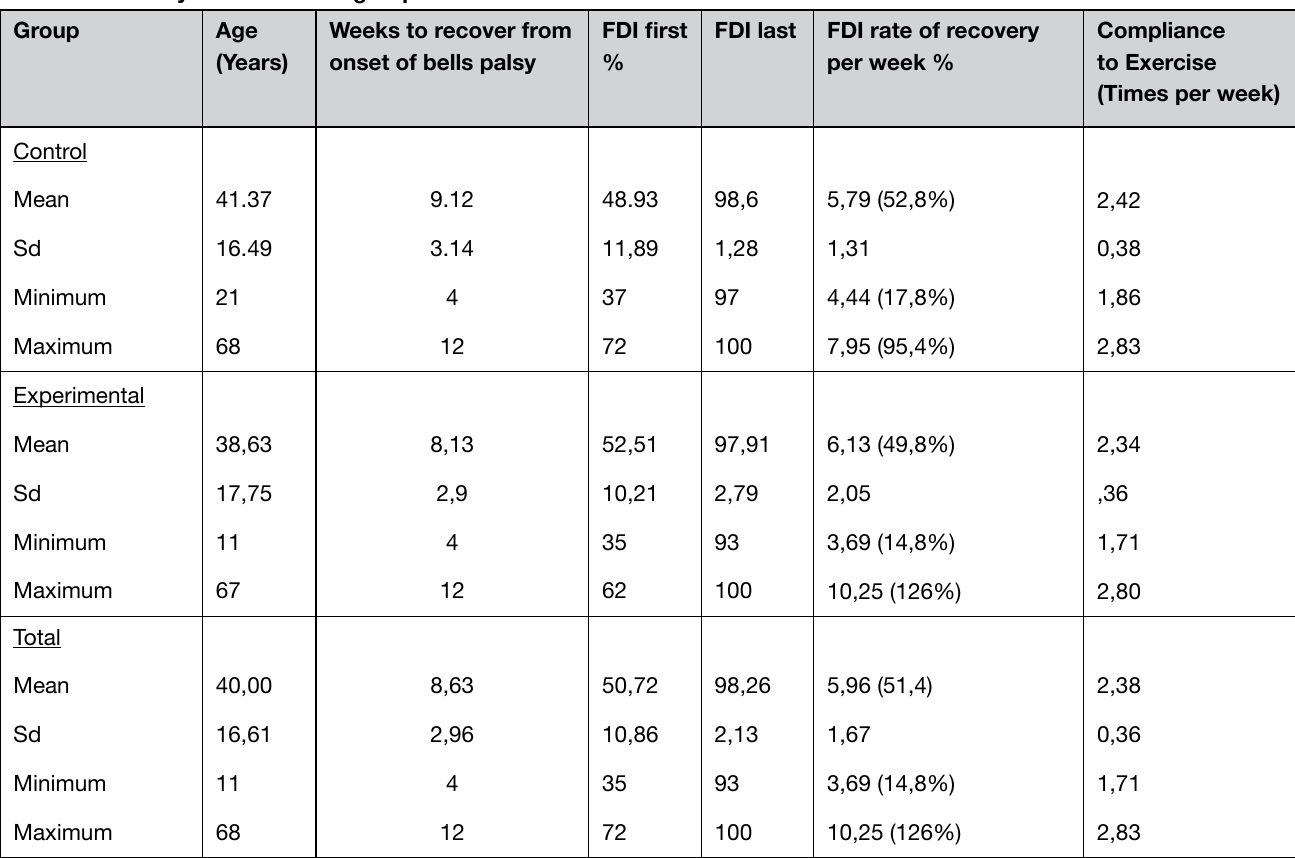
Table 4: Summary of data for the group Group Age